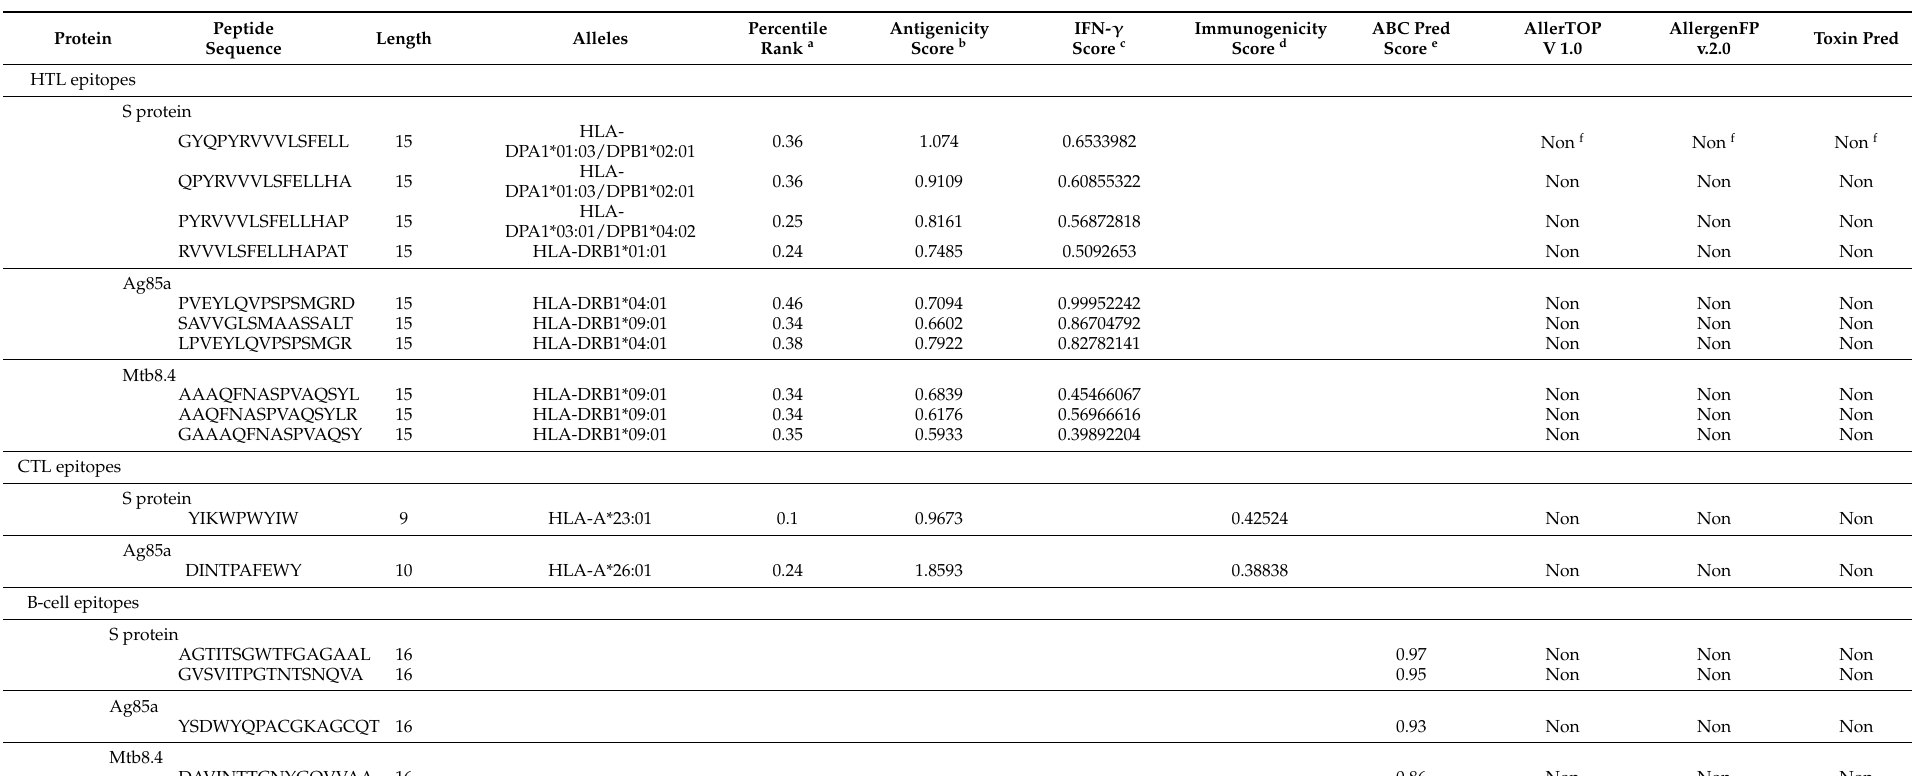
Table 1. Detailed information of the HTL, CTL, and B-cell epitopes used to construct the S7D5L4